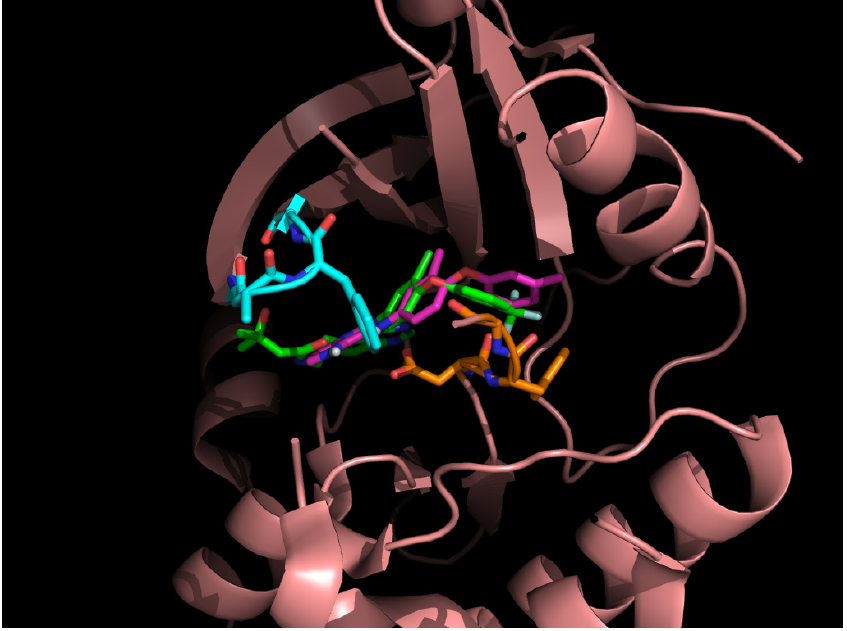
Figure 6. The docked compound 6m (purple) compared to the TAK-285 (green) within the HER2 crystal structure (PDB ID: 3RCD). The kinase P-loop (cyan) and DFG-motif (orange) were